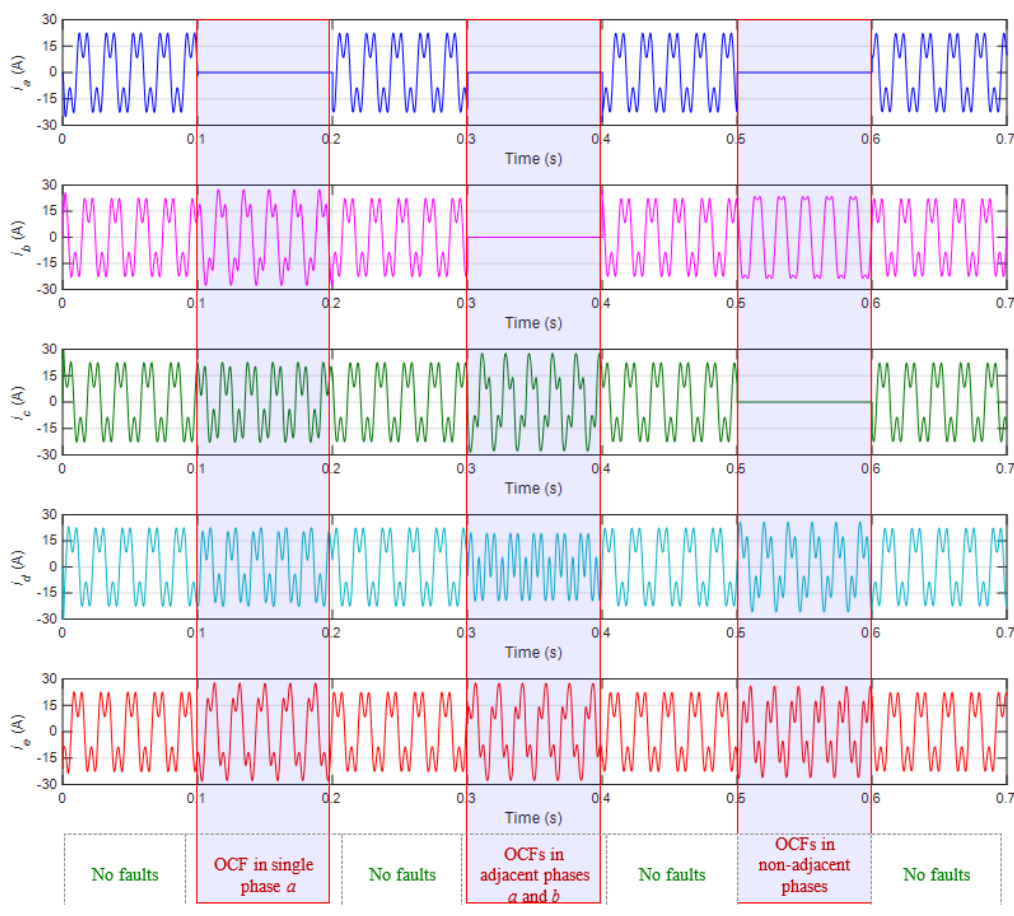
Figure 6. Phase currents of the FP-PMSG with three different open-circuit faults (OCFs) in the generator.